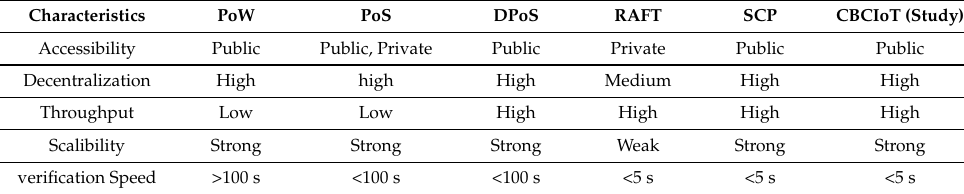
Table 4. Comparisons between consensus algorithms